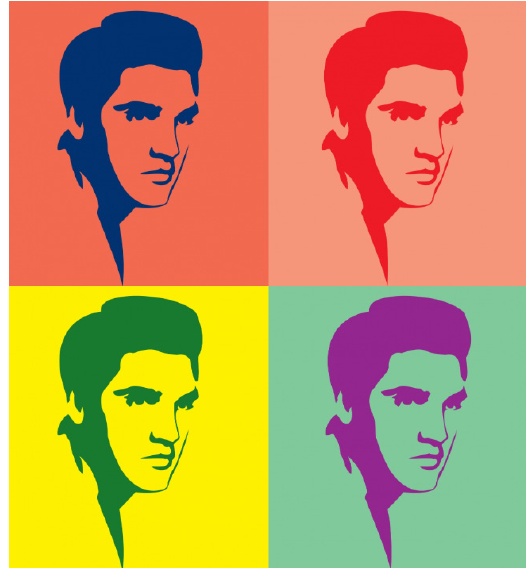
Figure 3. From left to right: original Yangliuqing New Year prints image; generated by “night café”; generated by “dream”; and generated by Vgg ‐ 19.